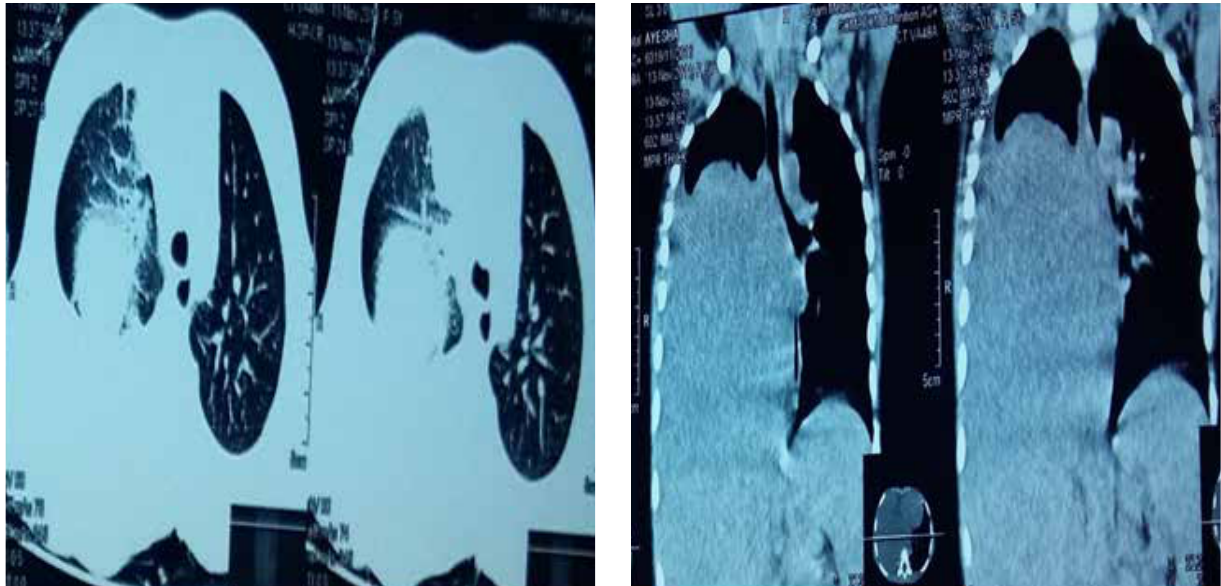
Fig 2. A large soft tissue mass in right chest with bilateral mediastinal lymphadenopathy, marked thick pleural thickening with dense